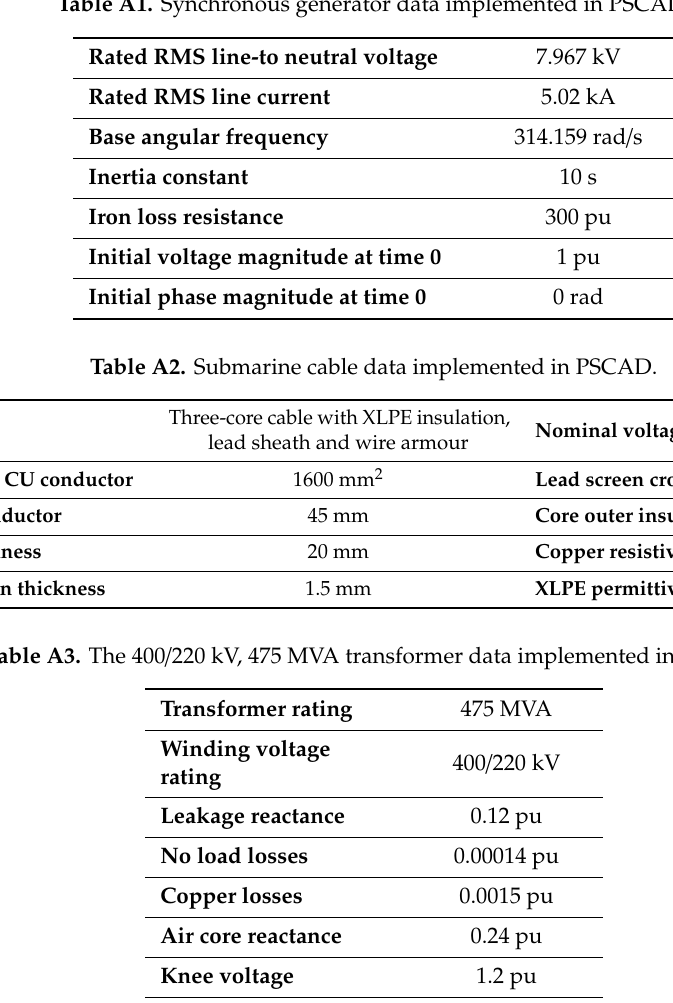
Table A1. Synchronous generator data implemented in PSCAD.